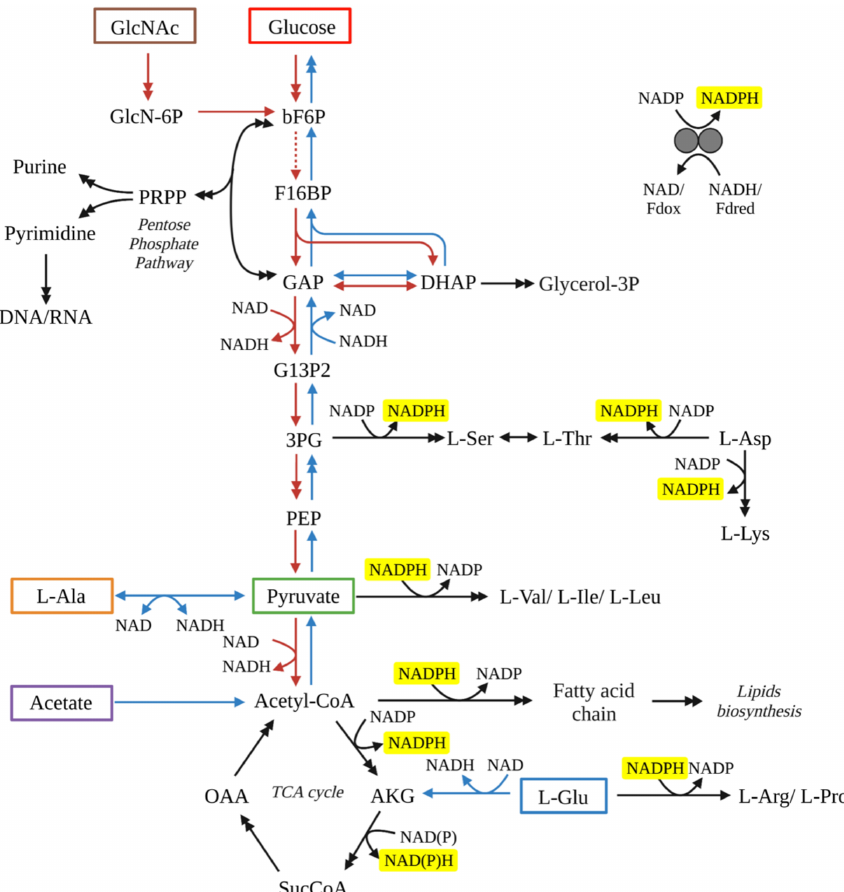
Figure 3. Schematic diagram of the metabolic pathways for WP3 by utilizing various substrates. Tested substrates in this study include GlcNac (brown box), glucose (red box), acetate (purple box), pyruvate (green box), L-alanine (orange box) and L-glutamate (blue box). Red arrows represent reactions through glycolysis pathways, while blue arrows represent reactions through glycogenesis pathway. Black arrows represent reactions required no matter which substrate was used. Double arrows indicate that multiple reactions are involved in the conversion between two compounds shown. All reactions with NADPH as a cofactor have been highlighted with yellow background. Abbreviations: 3PG, 3-phospho-D-glycerate; Akg, 2-oxoglutarate; bF6P, beta-D-fructose 6-phosphate; DHAP, dihydroxyacetone phosphate; F16BP, beta- D-fructose 1,6-bisphosphate; G13P2, D-glycerate 1,3-diphosphate; G6P, D-glucose 6-phosphate; GAP, glyceraldehyde 3-phosphate; GlcN- 6P, D-glucosamine 6-phosphate; GlcNAc, N-acetyl-D-glucosamine; Glycerol-3P, glycerol 3-phosphate; OAA, oxaloacetate; PEP, phospho- enolpyruvate; Pi, phosphate; PPi, diphosphate; SucCoA, succinate